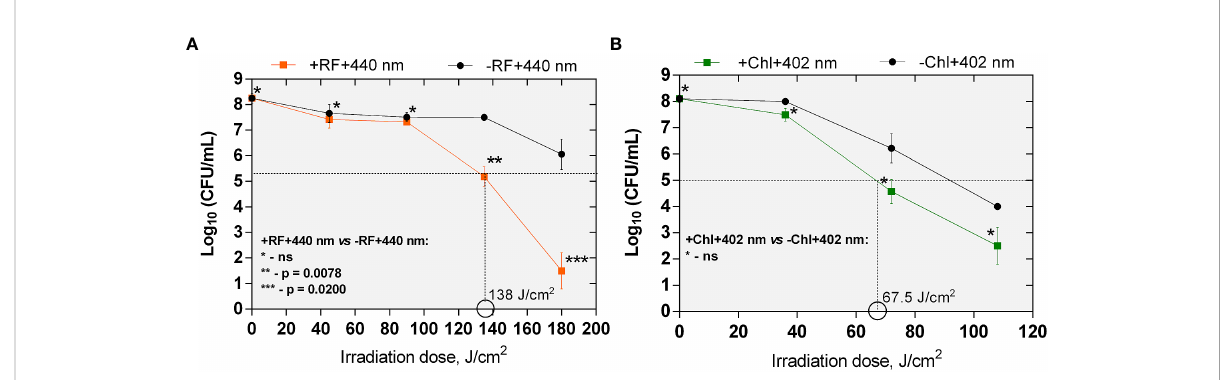
FIGURE 5 The effect of RF- (A) and Chl-API (B) on Brevundimonas sp. ESA1 bio fi lm. Horizontal and vertical dashed lines shown in the graphs indicate the minimal irradiation doses that were required to achieve 3 log 10 reduction of CFU counts of the tested bacterial bio fi lm. +RF +440 nm: irradiated